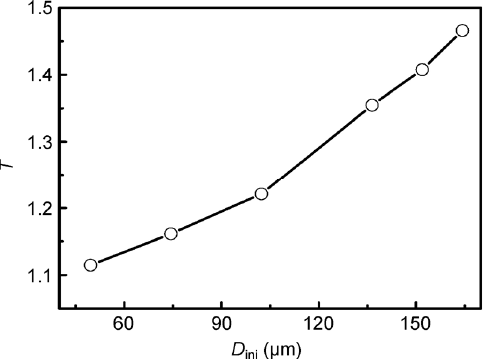
Fig. 16 Variations of time ratio T with initial droplet diameter D ini , PAO100, u e = 120.0 mm/s, w = 30